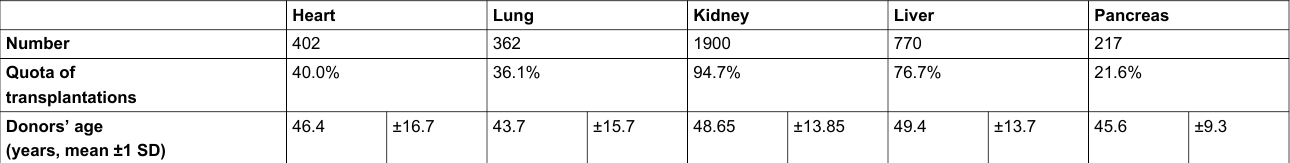
Table 1: Summary of the transplanted grafts 1998–2008 per organ (heart, lung, kidney, liver and pancreas (whole pancreas and islets); quota of transplantations = percentage of procured organs in relation to the total number of donors in this study (n = 1004)); average age of donor, displayed by procured organ. Results displayed as mean value ± 1. SD (standard